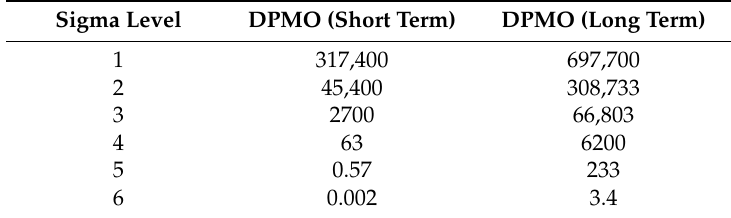
Table 6. Defects per million opportunities regarding sigma